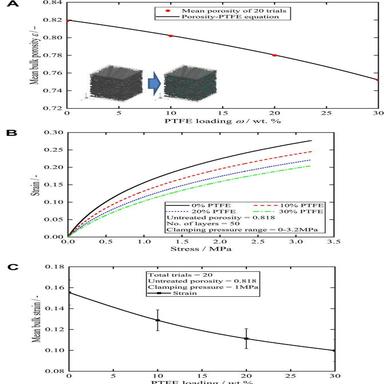
(a) Effects of the PTFE loading on the post-treated PTLs porosity variation, (b) the bulk mean strain variation for different PTFE loadings, and (c) the bulk mean stressestrain relationship as a function of the PTFE loading.